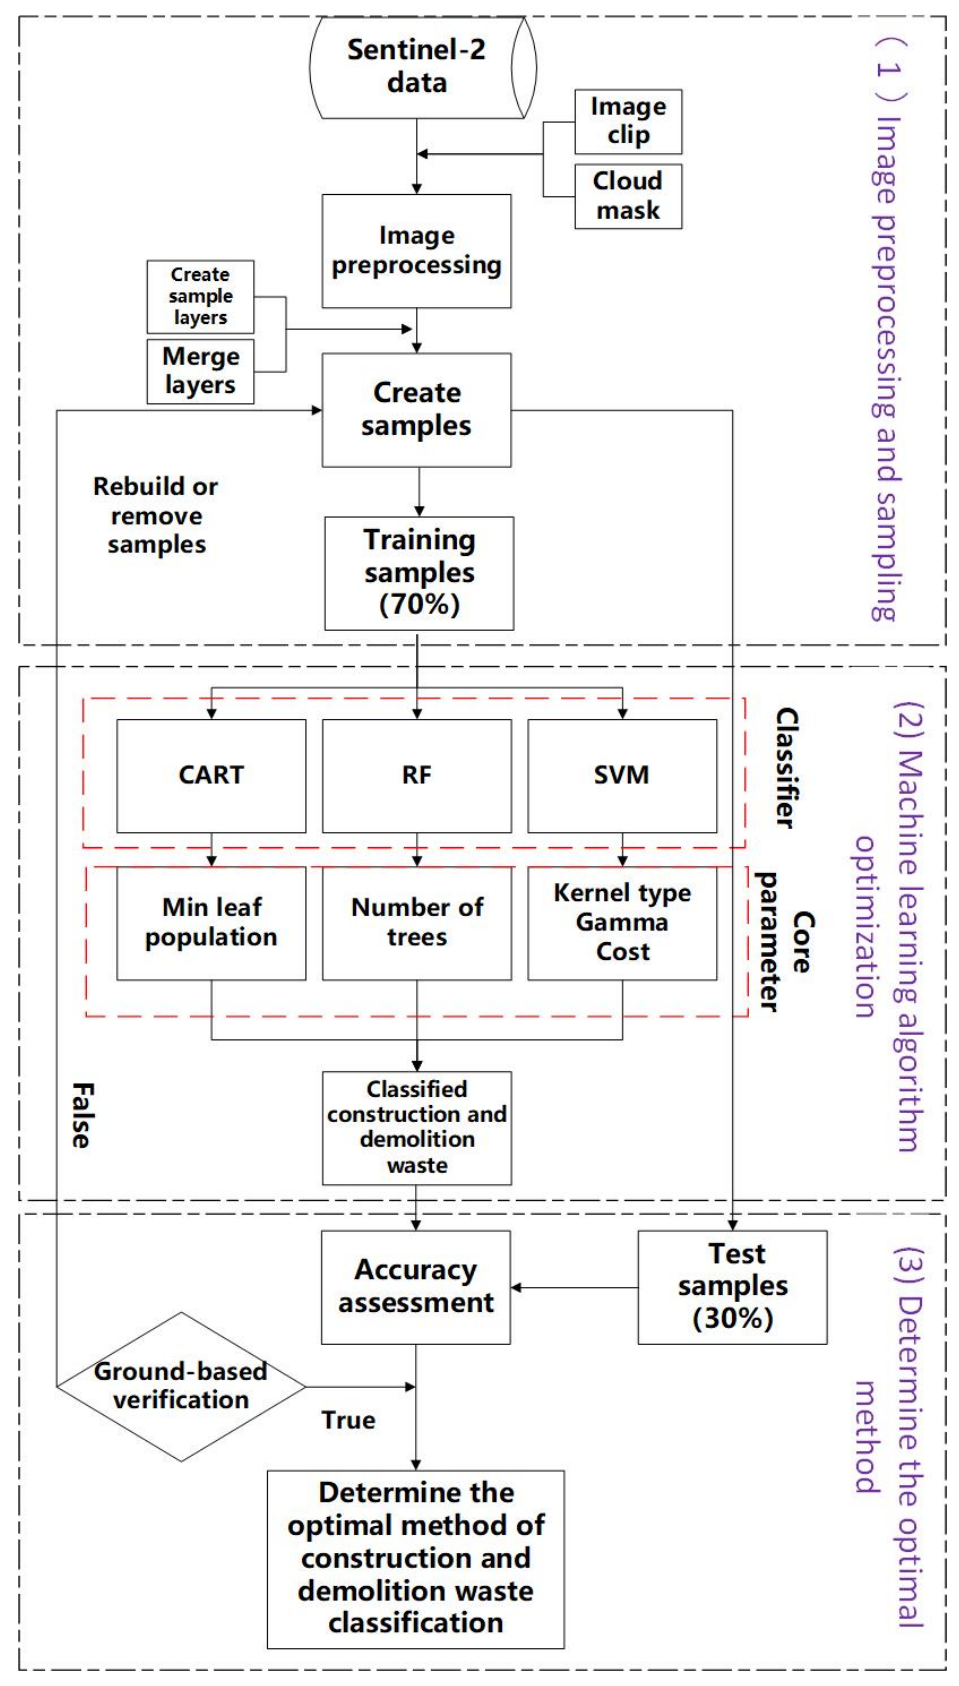
Figure 2. Methodological steps conducted for this study.